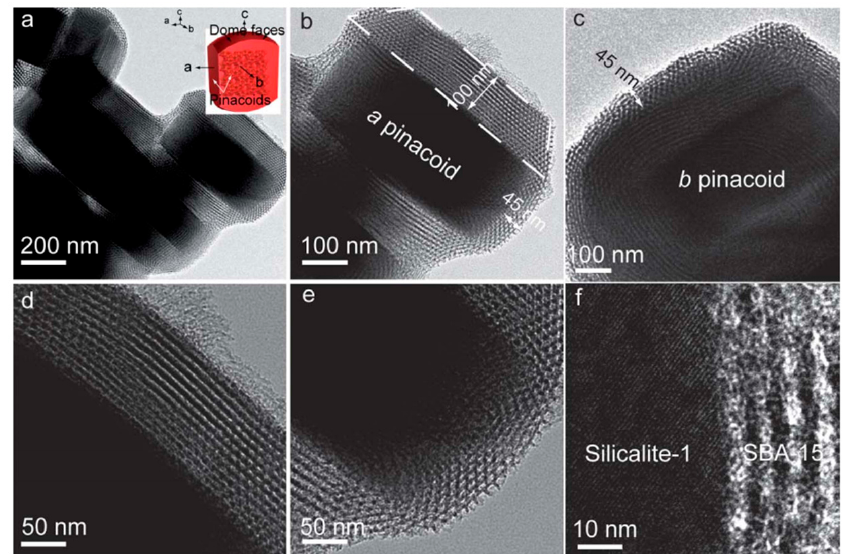
Figure 5. Transmission electron microscopy (TEM) images of a core ‐ shell structured composite Silicalite ‐ 1@SBA ‐ 15 with a well–defined mesostructured shell: ( a ) Uniform core ‐ shell particles without separated SBA ‐ 15; ( b ) a core ‐ shell particle with shell thickness of ca.100 nm on b pinacoid and of ca. 45 nm on dome face; ( c ) a core ‐ shell particle with shell thickness of ca.45 nm on a pinacoid; ( d ) strip–like mesopores and ( e ) hexagonal mesopores closely connected with Silicalite ‐ 1; ( f ) cross ‐ section High ‐ Resolution Transmission Electron Microscopy (HRTEM) image of the core ‐ shell composite revealing the highly interconnected micropores and mesopores. Inset in ( a ) is the geometric model of a Silicalite ‐ 1 single ‐ crystal. Reproduced with permission from [43]. Copyright Royal Society of Chemistry, 2011.